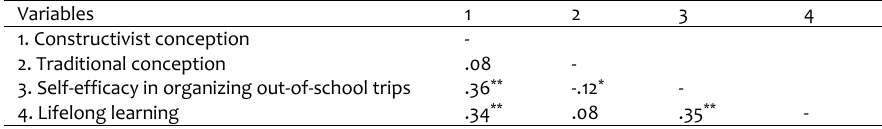
Table 2. Correlations between the variables